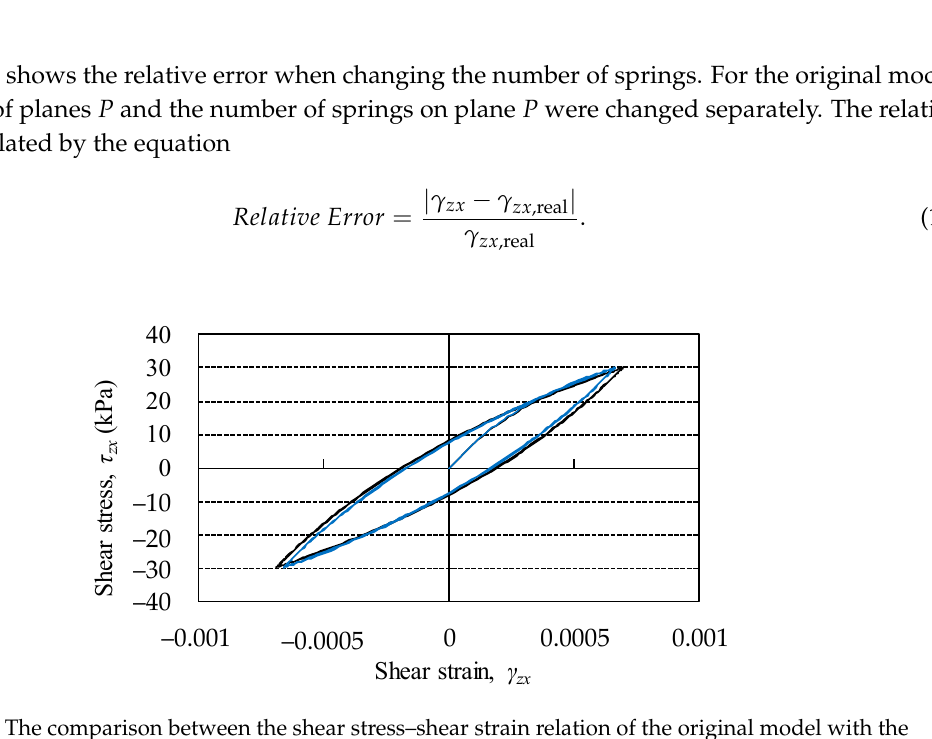
Figure 5. The comparison between the shear stress–shear strain relation of the original model with the proposed model. Black line is shown as the response of the original model and blue line is shown as that of the proposed model.